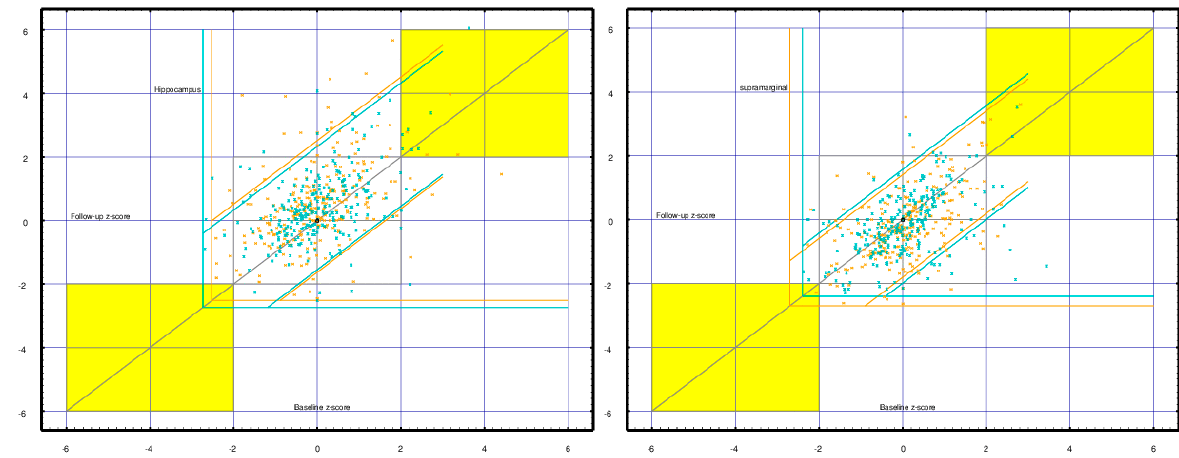
Figure 11. Baseline (x-axis) vs. 16-month follow-up (y-axis) z-score regional current densities are plotted for each CamCAN subject ( n = 253)—right brain in green, left brain in orange. The left panel shows the hippocampus. Correlations are 0.456 (L) and 0.476 (R); differences are 0.524 (L) and 0.408 (R). The right panel shows the supramarginal cortex. Correlations are 0.524 (L) and 0.482 (R); differences are − 0.264 (L) and − 0.194 (R). The significance of the differences is readily seen in the displacement of the upward (hippocampus) and downward (supramarginal) distributions. The horizontal and vertical green/orange lines indicate the right/left floor values for the measures. The diagonal lines are 2.0 z-scores from the mean difference. Yellow highlights the areas for which both baseline and follow-up z-scores are ≥ 2.0.